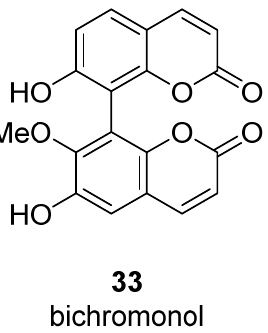
Figure 5. Structure of bichromonol 33 , a coumarin dimer.